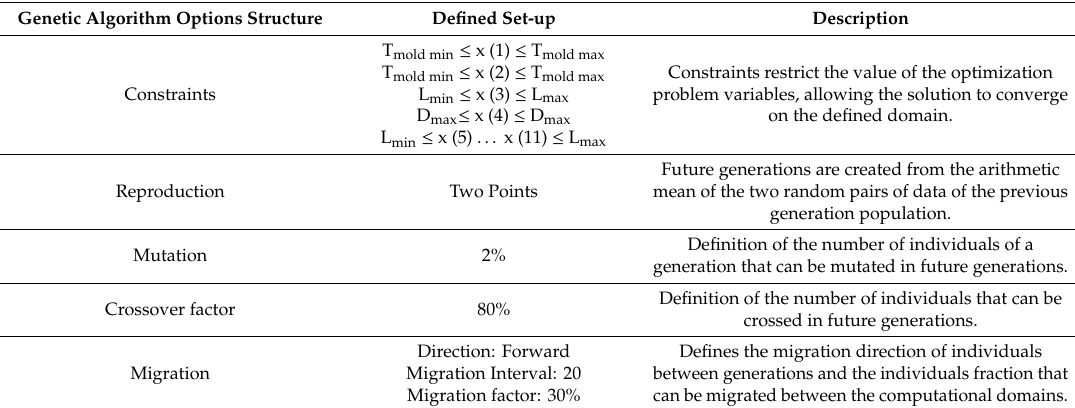
Table 3. Set-up of the genetic optimization algorithm.